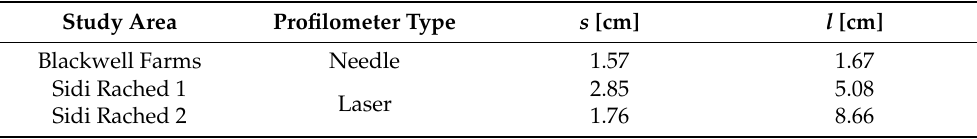
Table 6. The values of the measured surface roughness